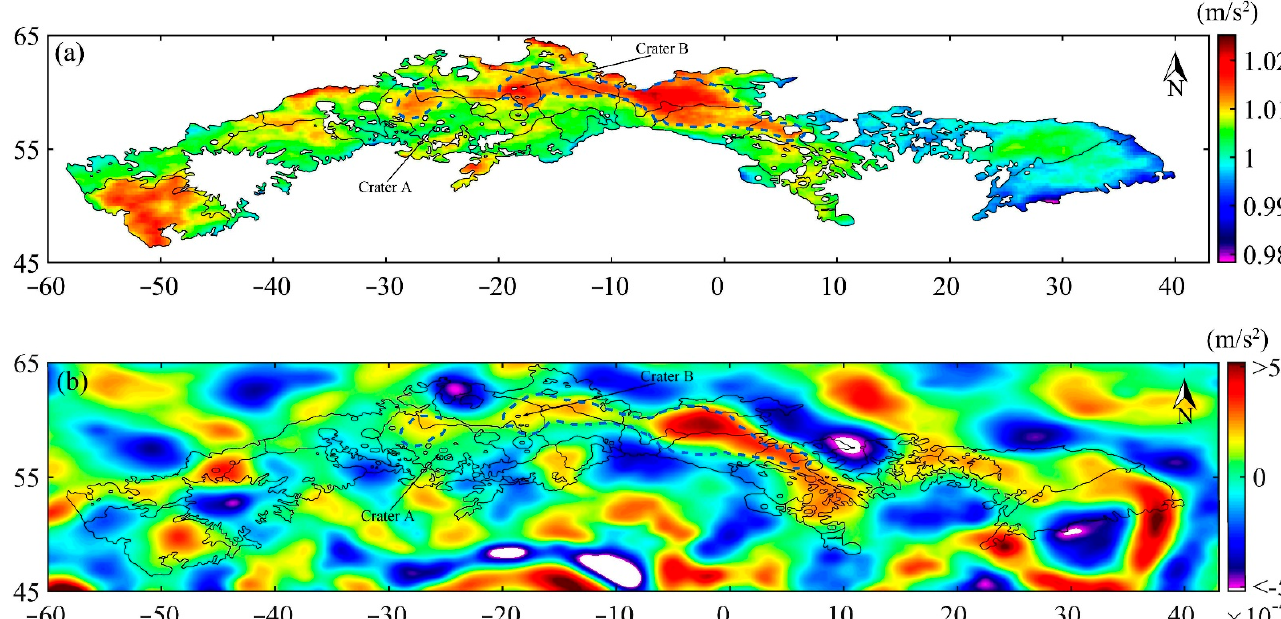
Figure 16. ( a ) 3.0-GHz normalized TB map at noon and ( b ) Bouguer gravity anomaly map of Mare Frigoris (equidistant cylindrical projection). The blue dash lines indicate the range of the warm microwave anomaly in Mare Frigoris. The black lines are the geologic boundaries of Mare Frigoris mapped by Kramer et al. [2].